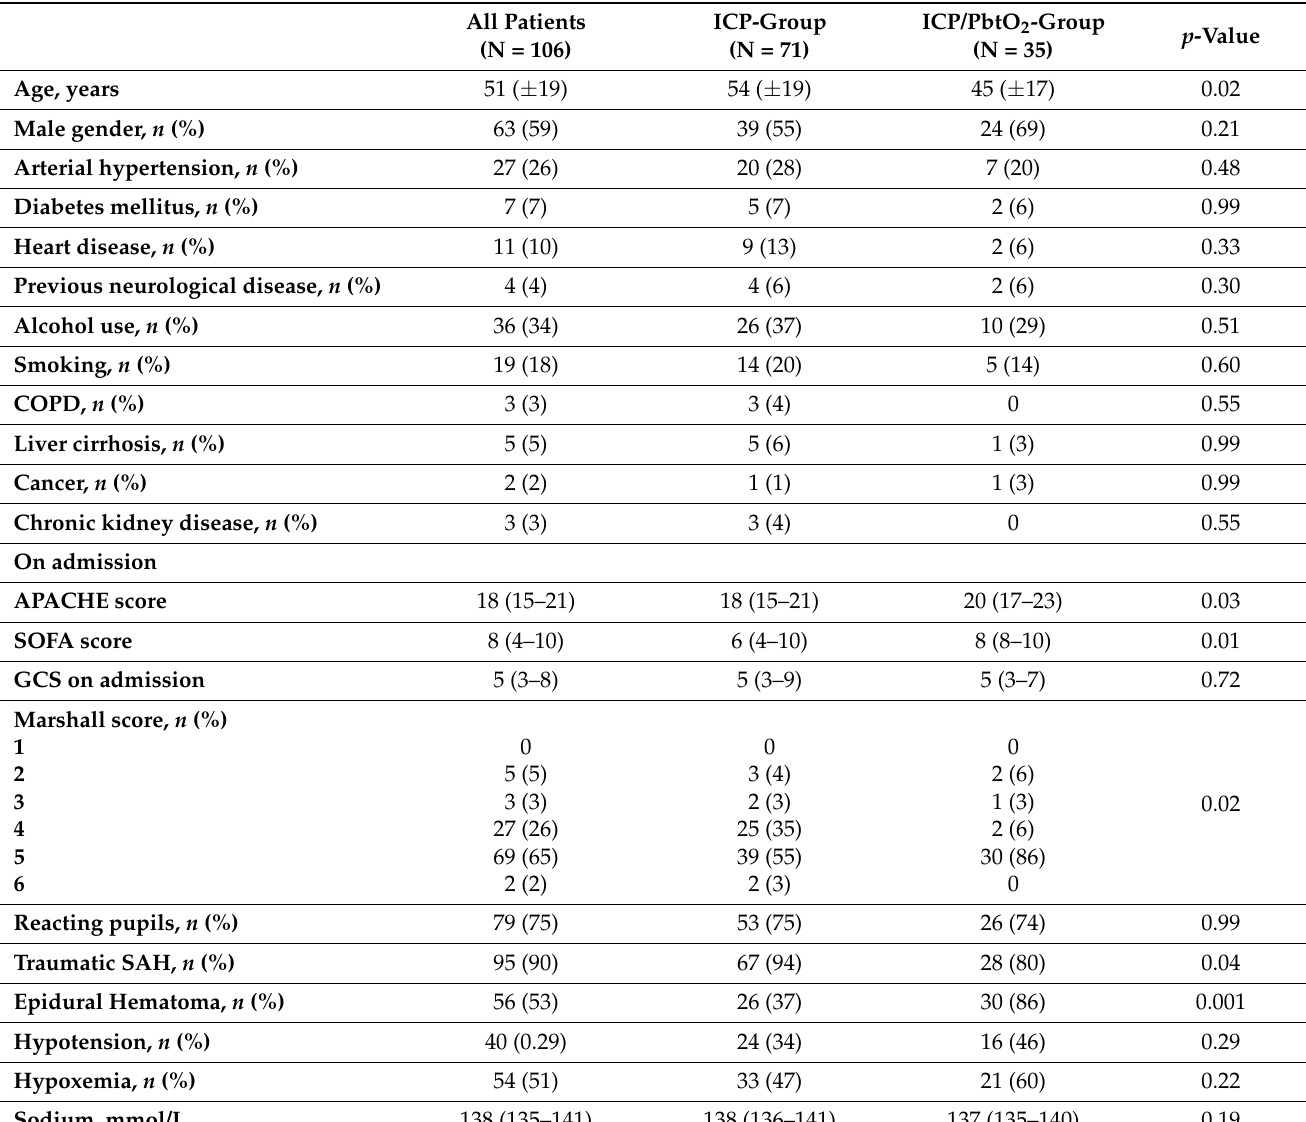
Table 1. Characteristics of the study population. Data are presented as mean ( ± SD), count (%) or median (25th–75th